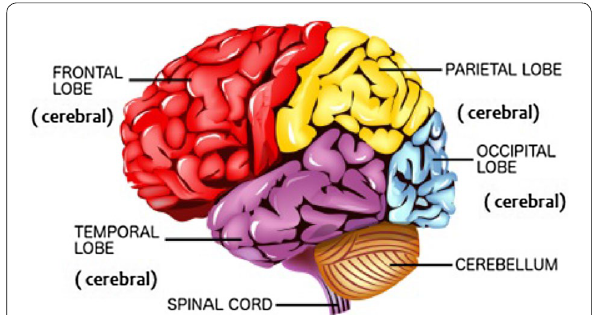
Fig. 1 Functional diagram of brain diagram is adopted from